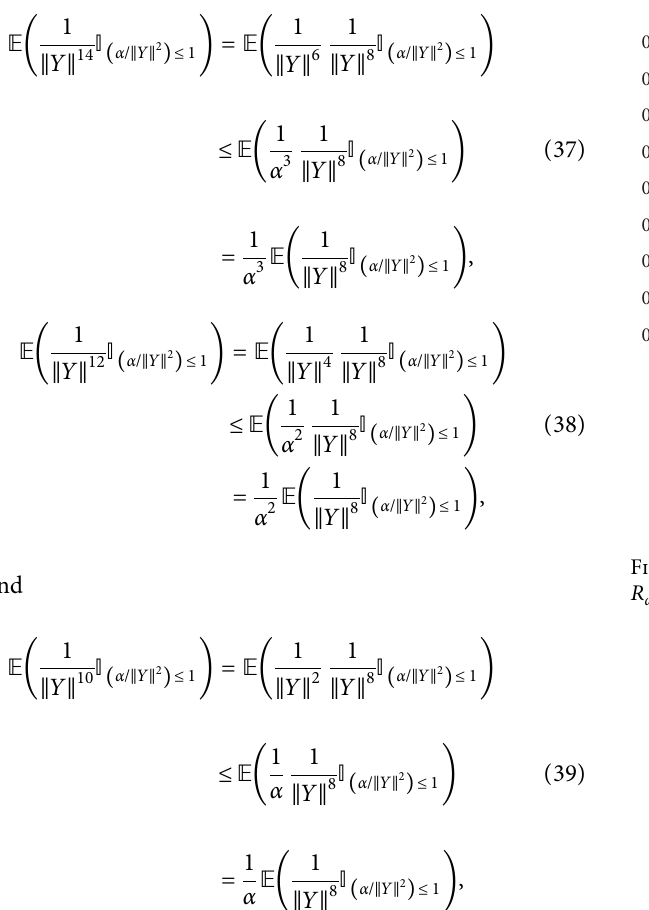
Figure 2: Curves of R ( Y, ] ) as functions of λ for d � 6 and ω � 0 . 5. R ω